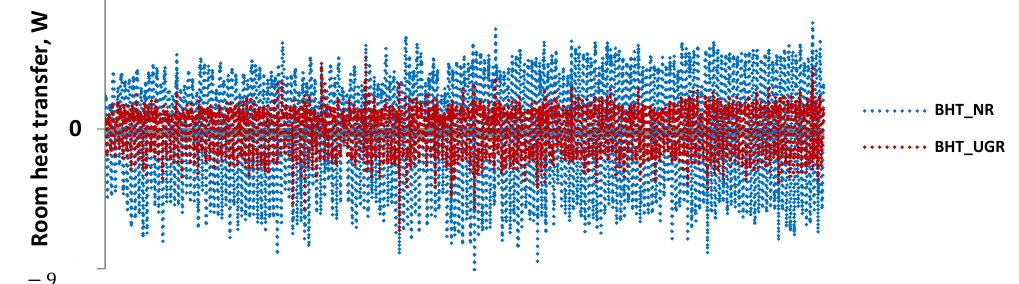
Figure 8. Building heat transfer comparison between underground and above ground rooms where BHT_NR is the above ground room and BHT_UGR is the underground room.